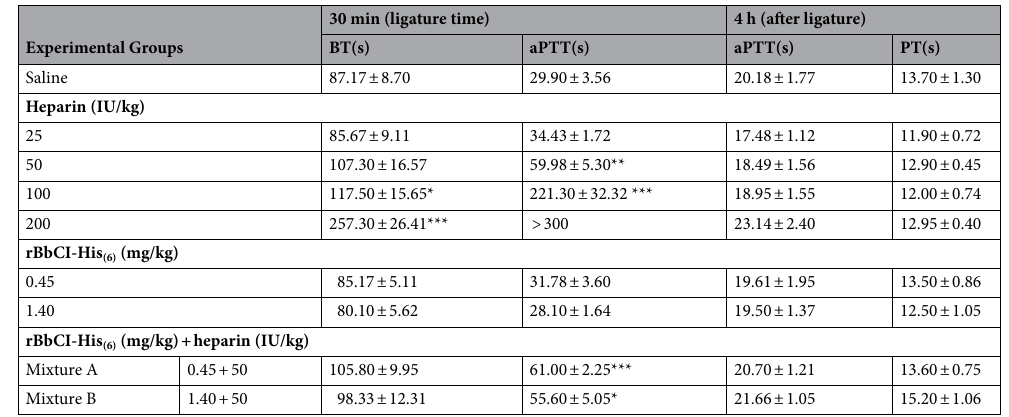
Table 3. Effect of substances (heparin and BbCl) at the time of ligature and after 4 h (ex-vivo) in the BT, aPTT, and PT parameters. BT and aPTT were determinate in tail and plasma respectively in rats treated intravenously with saline or heparin or rBbCI-His (6) or mixture, 30 min before the ligature vena cava (substances control group after a half-hour of treatment). aPTT and PT were realized in rat plasma after 4 h of the ligature (group ex‑vivo ). Values are presented as mean ± s.d.. * p ˂ 0.05, ** p ˂ 0.01, *** p ˂ 0.001 versus corresponding values of plasma tested with saline. BT- bleeding